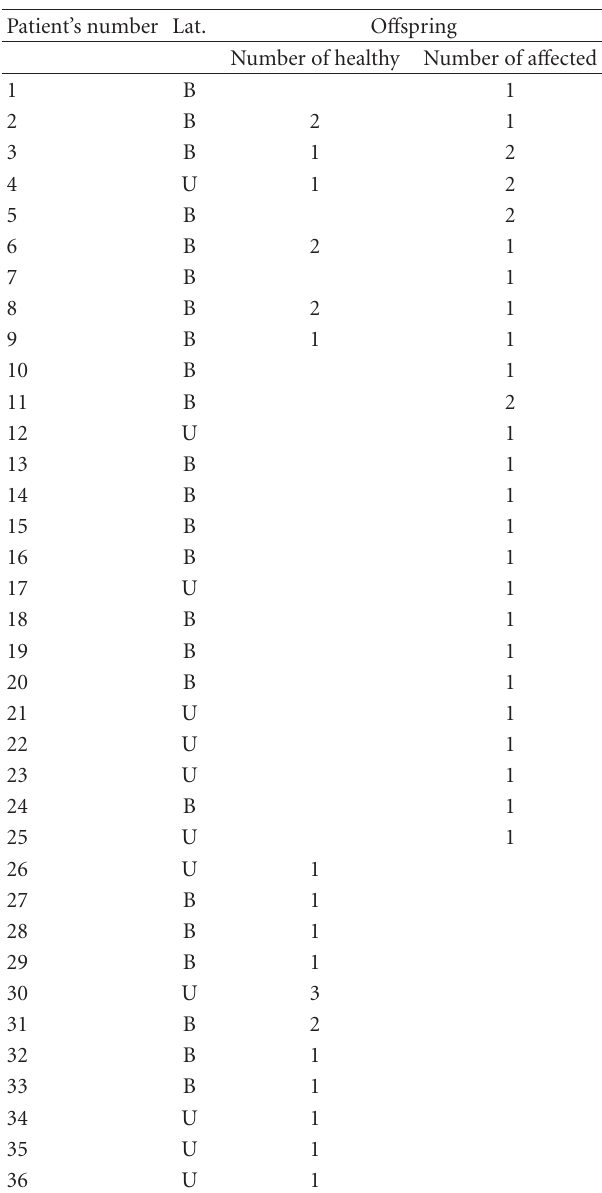
Table 1: Distribution of retinoblastoma by type and laterality [6]. Table 2: A list of 36 retinoblastoma survivors and their o ff spring referred to the Ocular Oncology Unit of the Department of Bilateral Unilateral Total Ophthalmology of the University of Siena (Italy). Unilaterally a ff ected survivors generated a total of 16 children, half of which Hereditary 25%–30% 10%–15% 35%–45% resulted a ff Nonhereditary 0 55%–65% 55%–65% Total 25%–30%